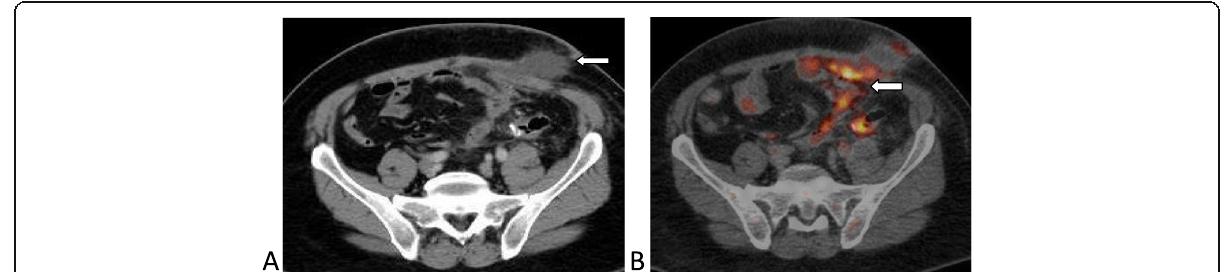
Fig. 1 A 52-year-old male patient who underwent surgical resection for pathologically proven colonic adenocarcinoma followed by chemotherapy and radiotherapy and follow-up 6 months later revealed a normal tumor marker level. a Axial post-contrast CT image showing operative bed fluid collection (seroma) with no enhancing component (arrow), b axial fused PET – CT image showing avid metabolic activity at the